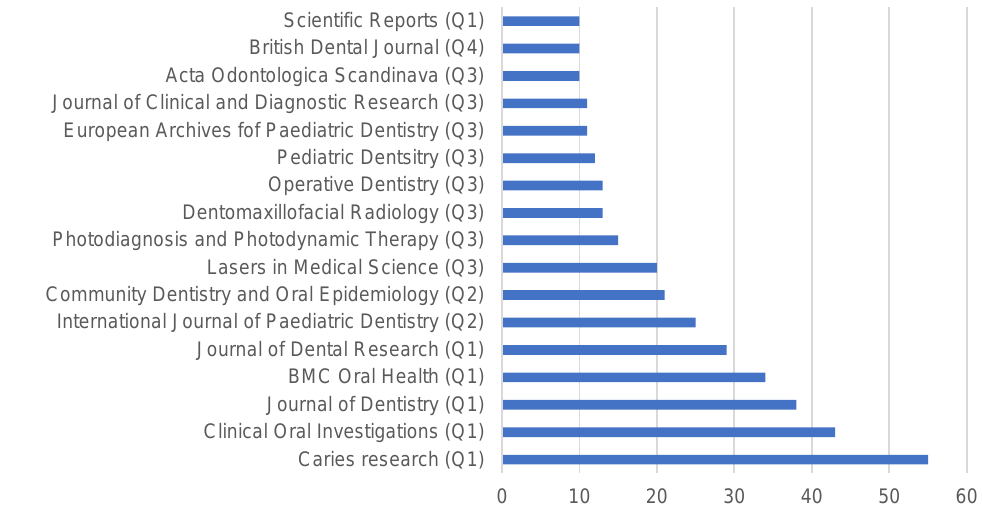
Figure 4. Journals with at least 10 publications with the topic “caries diagno*” or “caries detect*”.